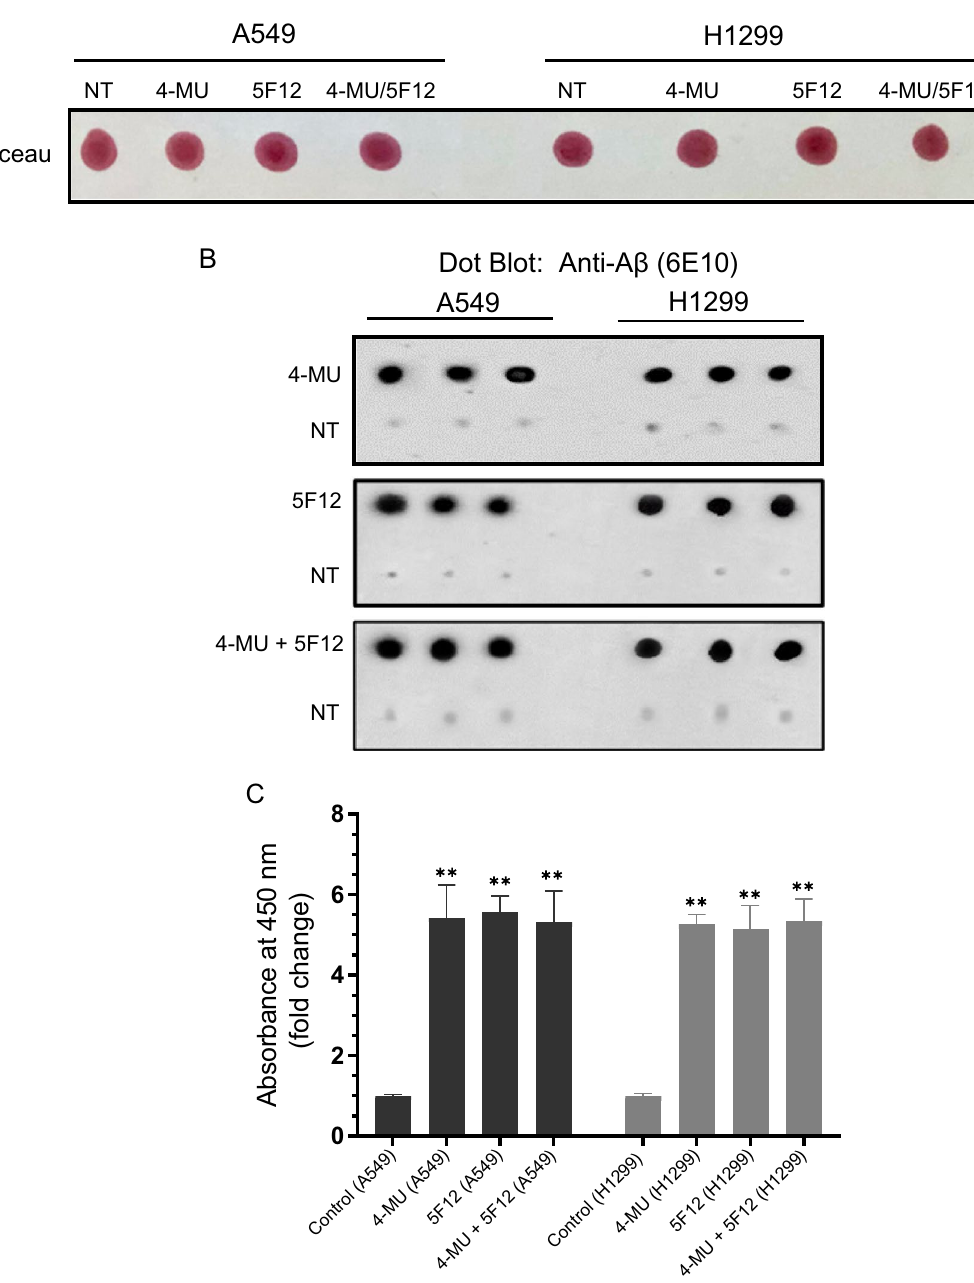
Figure 1. Treatment of cells with either 4-MU or 5F12 resulted in increased Aβ in the media of A549 and H1299 cells. Cells (0.2 × 10 5 ) were grown in 10% FBS-supplemented media for 24 h. The following day, the cell monolayers were incubated in serum-free media for 24 h, then treated as indicated for 72 h with 600 µM 4-MU and/or the CD44 antibody (5F12, 5 μg/mL). The media was collected then the same amount of protein (3 µL of 600 µg/mL total protein) of each sample not-treated (NT) or treated as indicated, was spotted onto a nitrocellulose membrane. The blots were stained with Ponceau ( A ). ( B ) Blots were incubated with anti-Aβ (6E10) antibodies, and the signal on the membrane was detected using super signal west pico luminol (chemiluminescence) reagent. The membranes were imaged with a Bio-Rad molecular imager, and quantitated with Image J. The dots from five independent assays, each carried out in triplicate, were quantitated, averaged, normalized, and expressed as fold change relative to untreated control cells after subtraction of the values for the blank consisting of dot blots probed with mouse IgG isotype control with no relevant specificity to a target antigen (mIgG, 5 μg/mL) or anti-Aβ (6E10) antibodies incubated with blots dotted with media not incubated with cells ( C ) using the GraphPad 8.4.3 software. The graphs summarize the results expressed as means ± SD (n = 5). Asterisks (*) indicate a statistically significant difference from the corresponding cell line control, ** p < 0.0l of each cell line, Mann–Whitney